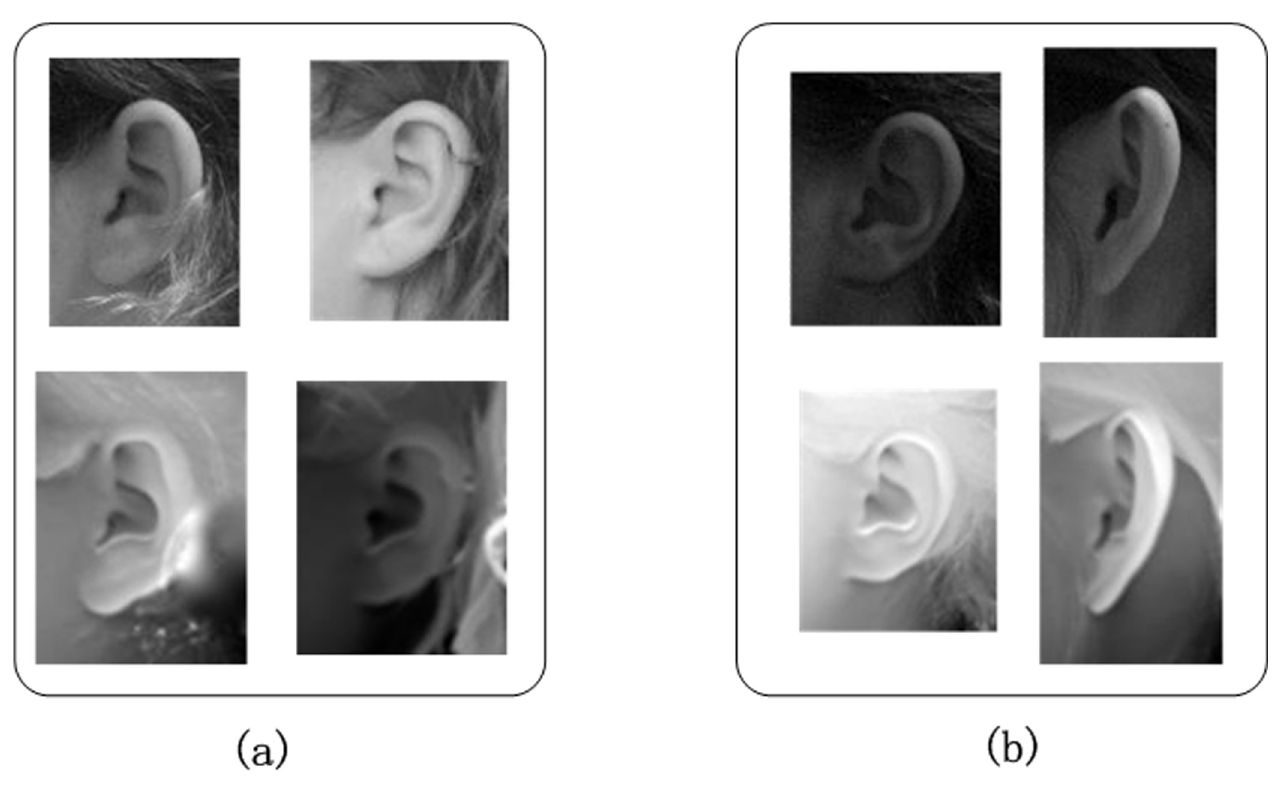
Fig 7. Examples of Case 1 and Case 2. (a) Case 1. (b) Case